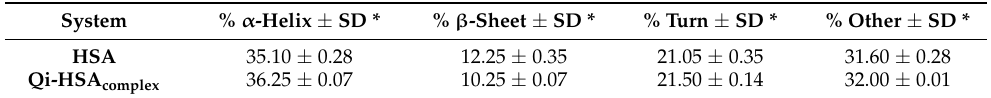
Table 4. The percentage (%) content of the secondary structure elements of HSA, in both the presence and absence of Qi (Qi:HSA 6.67:1 molar ratio); Young’s reference